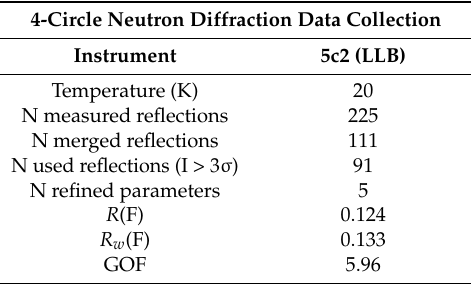
Table 2. Details of the 4-circle neutron data collection and thermal parameter